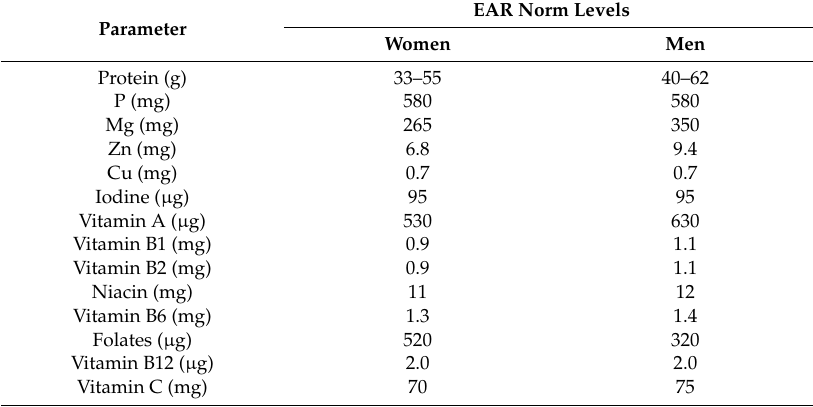
Table 2. The assumed nutritional